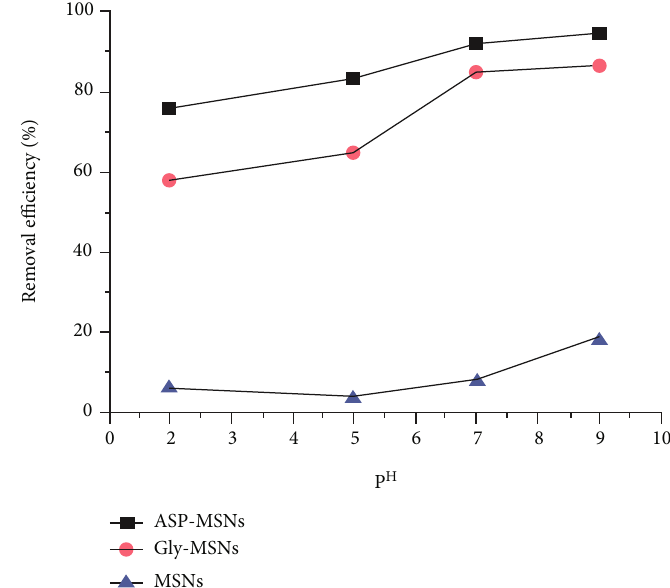
· L, V =10mL, T =298K). 0 =50mg